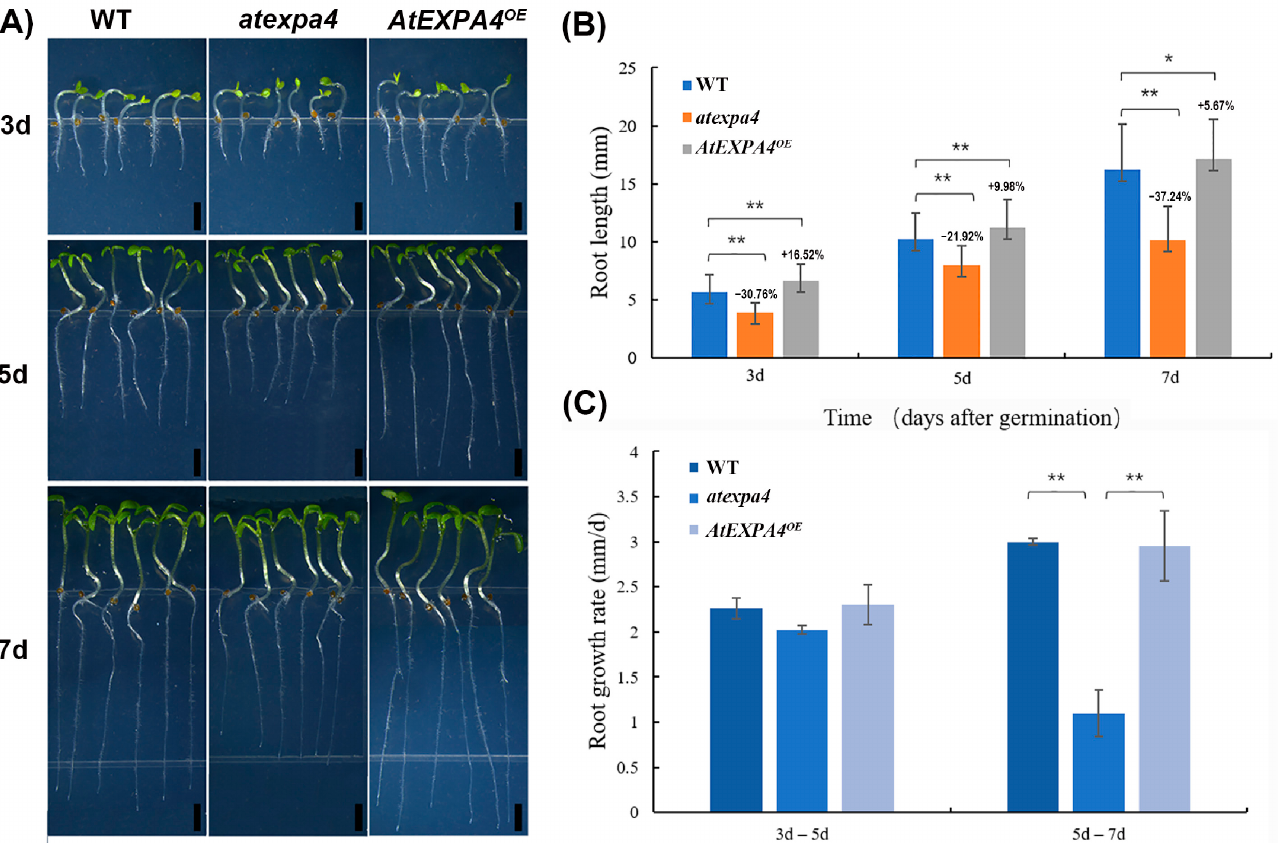
Figure 6. AtEXPA4 positively regulates primary root elongation. ( A ) AtEXPA4 OE and atexpa4 seedlings germinated and grown for 3, 5, and 7 days, scale bars, 2 mm. ( B ) Root lengths in ( A ). ( C ) Root growth rates from the 3rd day to the 5th day and from the 5th day to the 7th day after seed germination. Values are means, error bars are SD, n ≥ 25 seedlings per replicate, three biological replicates, t -tests as ** p < 0.01 and * p <